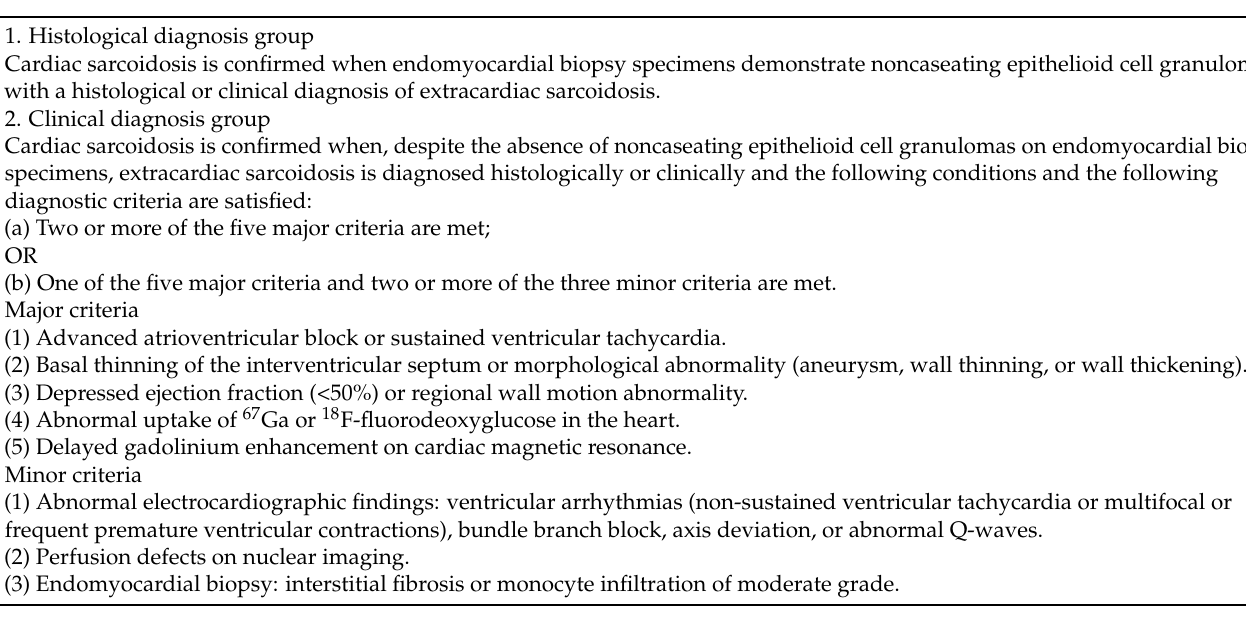
Table 1. The Japanese Society of Sarcoidosis and other Granulomatous Disorders (JSSOG) 2015 criteria for cardiac sarcoido- sis